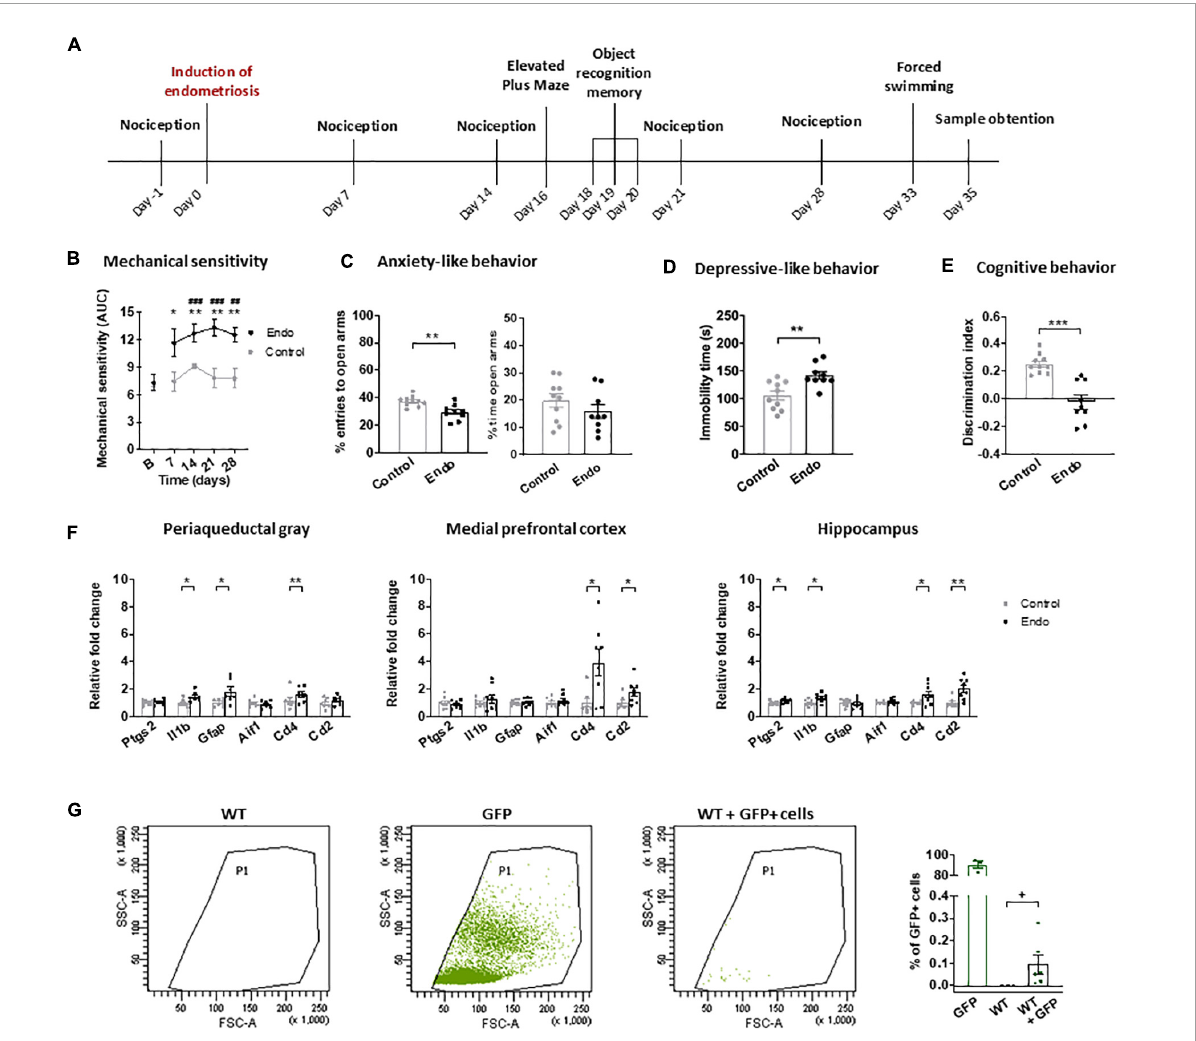
FIGURE1 Behavioral and neuroinflammatory alterations in endometriosis mice. (A) Timeline of the behavioral experiment and sample collection. Endometriosis mice showed (B) persistent mechanical hypersensitivity in the abdomino-pelvic area after stimulation with von Frey filaments, (C) increased anxiety-like behavior in the elevated plus maze test, (D) increased depressive-like behavior in the forced swimming test and (E) cognitive impairment in the novel object recognition task. [ (F) left panel] Endometriosis mice showed increased expression of interleukin 1-beta ( Il1b ), astrocyte marker GFAP ( Gfap ) and leucocyte marker CD4 ( Cd4 ) in periaqueductal gray; [ (F) central panel] overexpression of leucocyte markers CD4 ( Cd4 ) and CD2 ( Cd2 ) in medial prefrontal cortex, and [ (F) right panel] high levels of cyclooxygenase 2 ( Ptgs2 ), interleukin 1-beta ( Il1b ), CD4 ( Cd4 ) and CD2 ( Cd2 ) in hippocampus. Microglia marker IBA1 (Aif1) was unaltered. (G) Flow cytometry revealed 0.095 ± 0.042% GFP + cells in the peritoneum of WT mice 35 days after injecting GFP + endometrium. Error bars are mean ± SEM. (B) Mixed-model analysis (C–E) Student’s t -test. (F,G) Student’s t or Mann–Whitney U according to normality. ## p < 0.01, ### p < 0.001 vs baseline; * p < 0.05, ** p < 0.01, *** p < 0.001 vs control; + p < 0.05 vs wild-type. Endo, endometriosis; AUC, area under the curve; GFP, green fluorescent protein; WT,